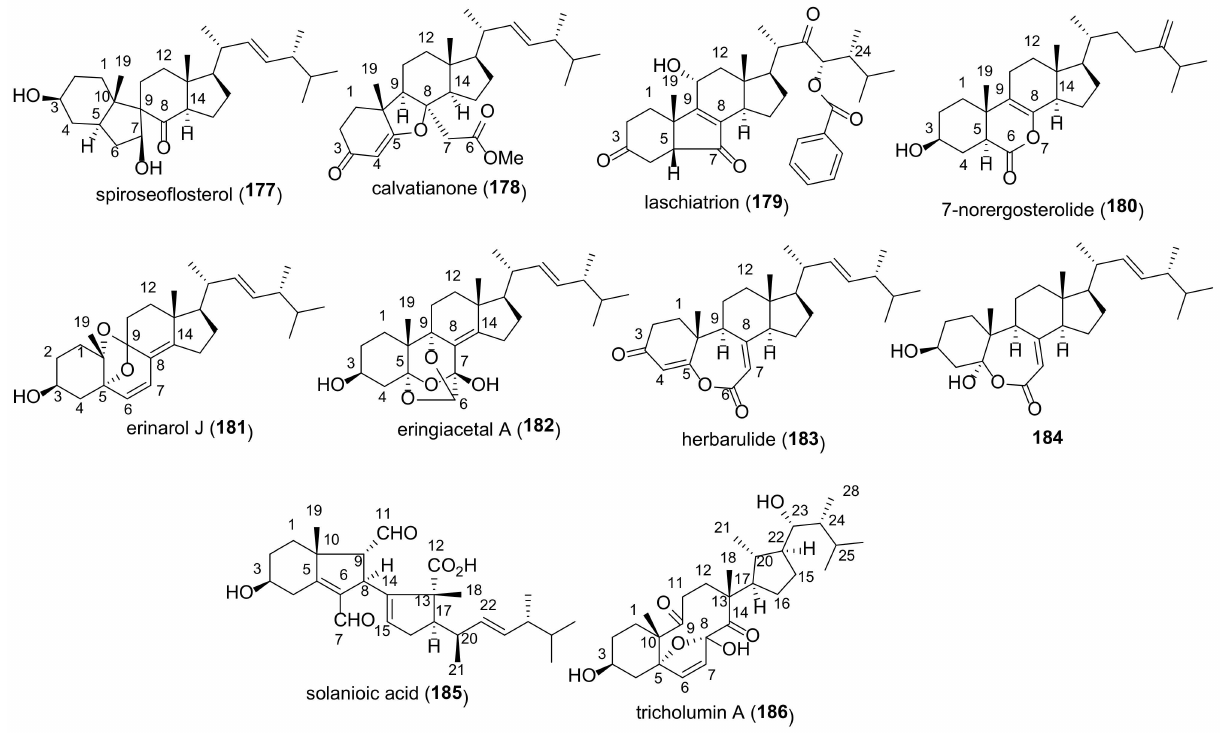
Figure 19. Structures of ergostanes with a rearranged